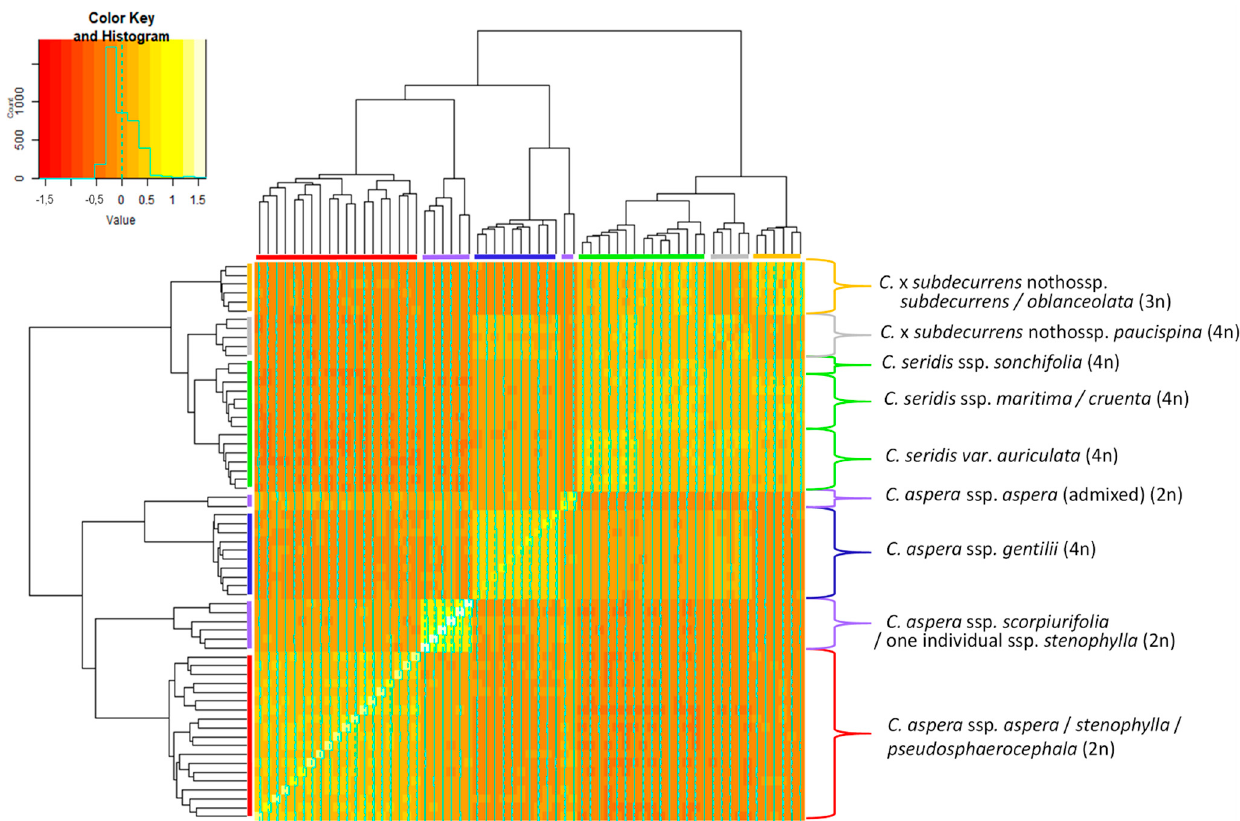
Figure 2. Heatmap depicting genomic relationships between the studied Centaurea individuals. Individuals are across the vertical and horizontal axes, with each square indicating the genomic relationship between the two respective individuals. The magnitude of the relationship is indicated by the colour range as shown in the colour key (1 being the relationship between an individual and itself and 0 being the mean of the data set). Colours in the branches of the tree correspond to different populations/taxa.